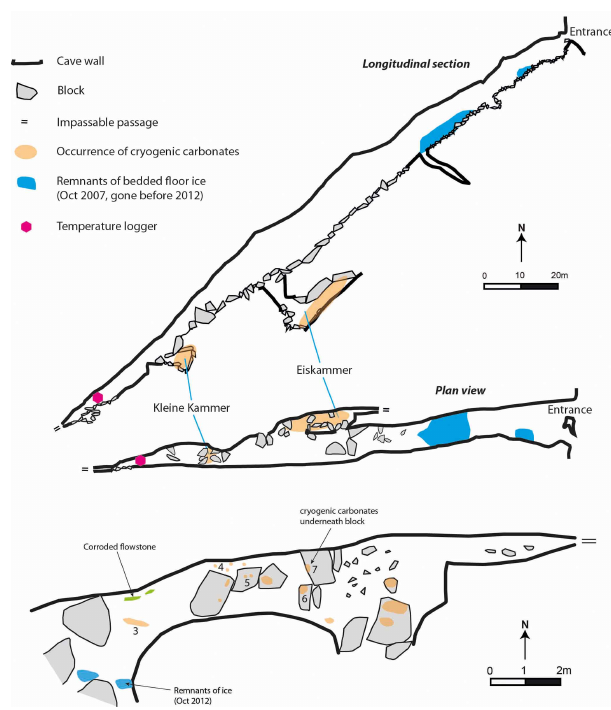
Figure 3. Longitudinal section and plan view of MSK Cave, show- ing the occurrence of CCC coarse (light brown), and enlargement of the plan view of the Eiskammer (lower panel). Cave survey by C. Spötl and G. Moseley. Numbers refer to samples of CCC coarse sampled in this study, whereby MSK1 and 2 were obtained from the Kleine Kammer and MSK3 to 7 from the